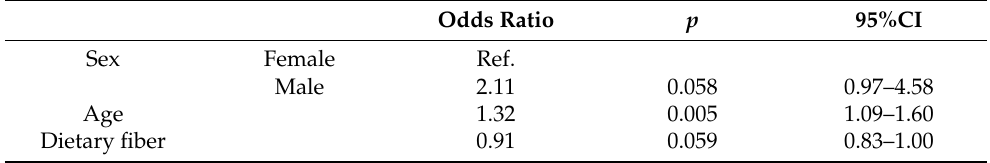
Table 2. Odds ratio of sleep bruxism.